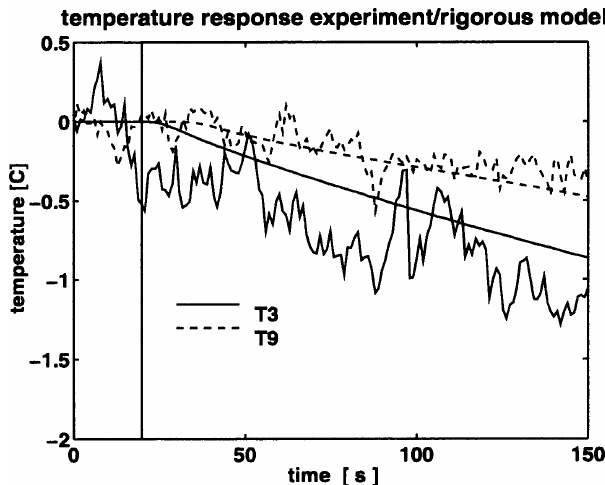
Figure 5. Experiment 3. Initial response of temperatures on trays 3 and 9 to a step change in reflux flow at t ó 20s.